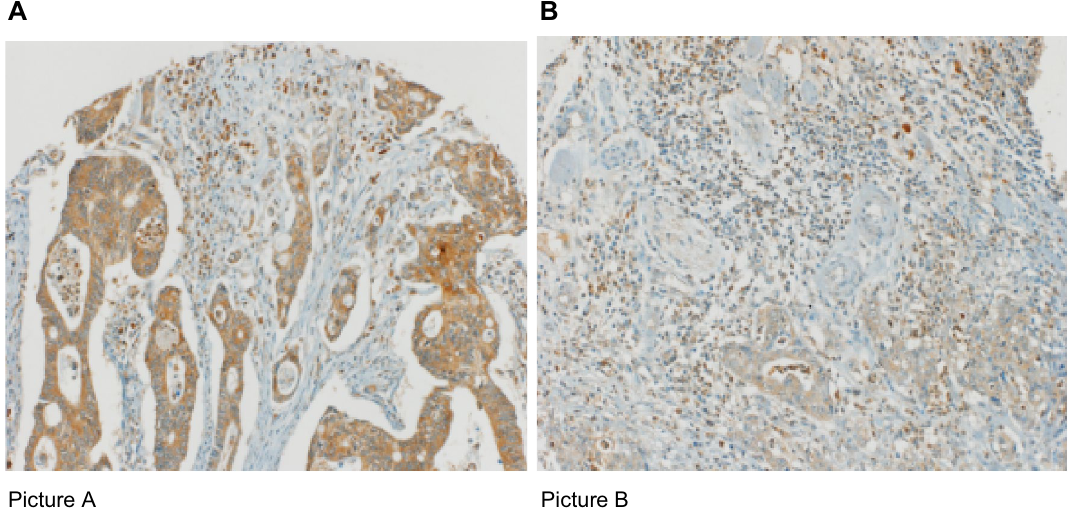
Figure 1. Examples of high SDF-1 expression ( A ) and low SDF-1 expression ( B ) in CRC biopsies with high CD8+ T-cell infiltration (× 200